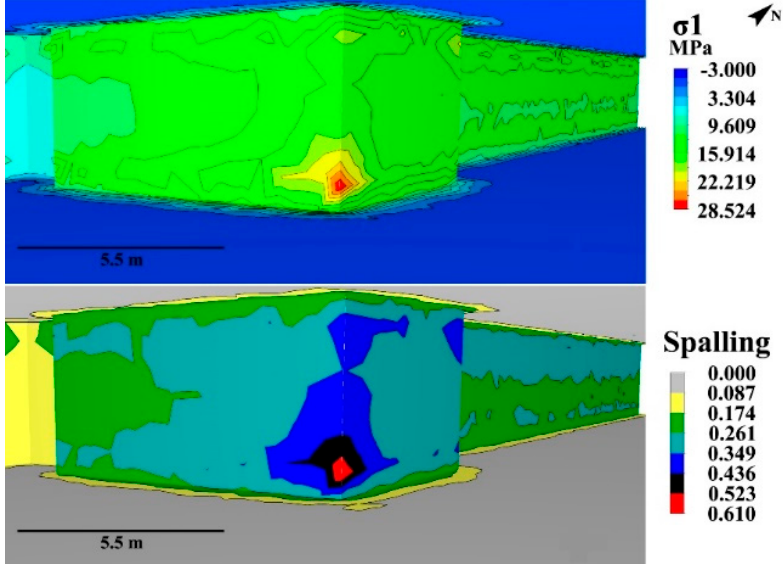
Figure 8. Spatial distribution of major principal field stress σ 1 ( top ) and spalling ratio values ( bottom ), considering transversely elastic anisotropic material (year 2016). The scale bar is indicative